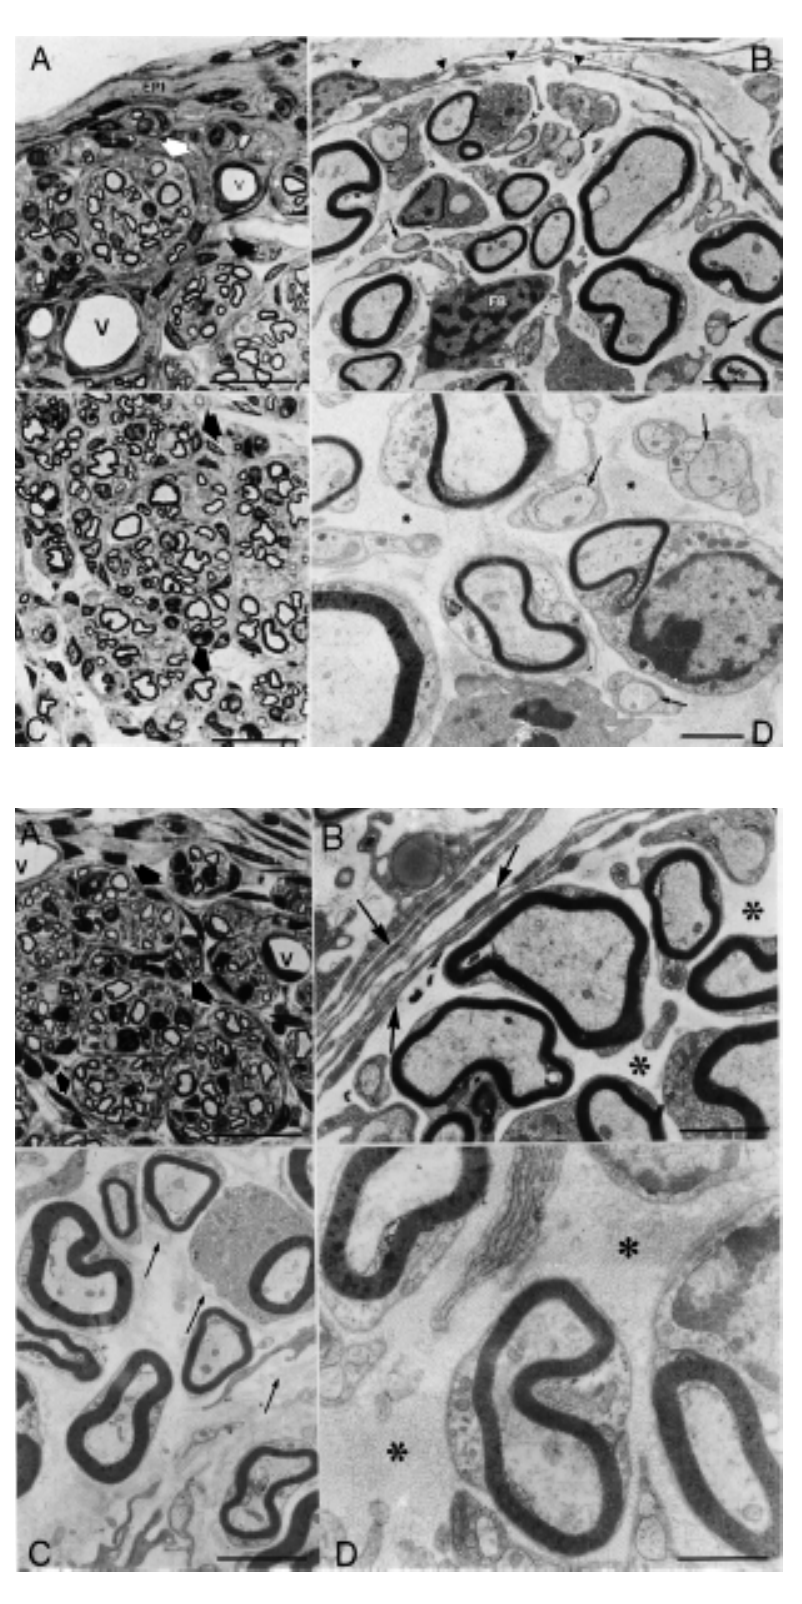
Figure 3 - A , Transverse semithin section of a regener- ated nerve 4 weeks after graft transplantation. Donor: C57BL/6J, recipient: F1 (C x A). The epineurium (EPI) is composed of multiple layers of flattened cells and the